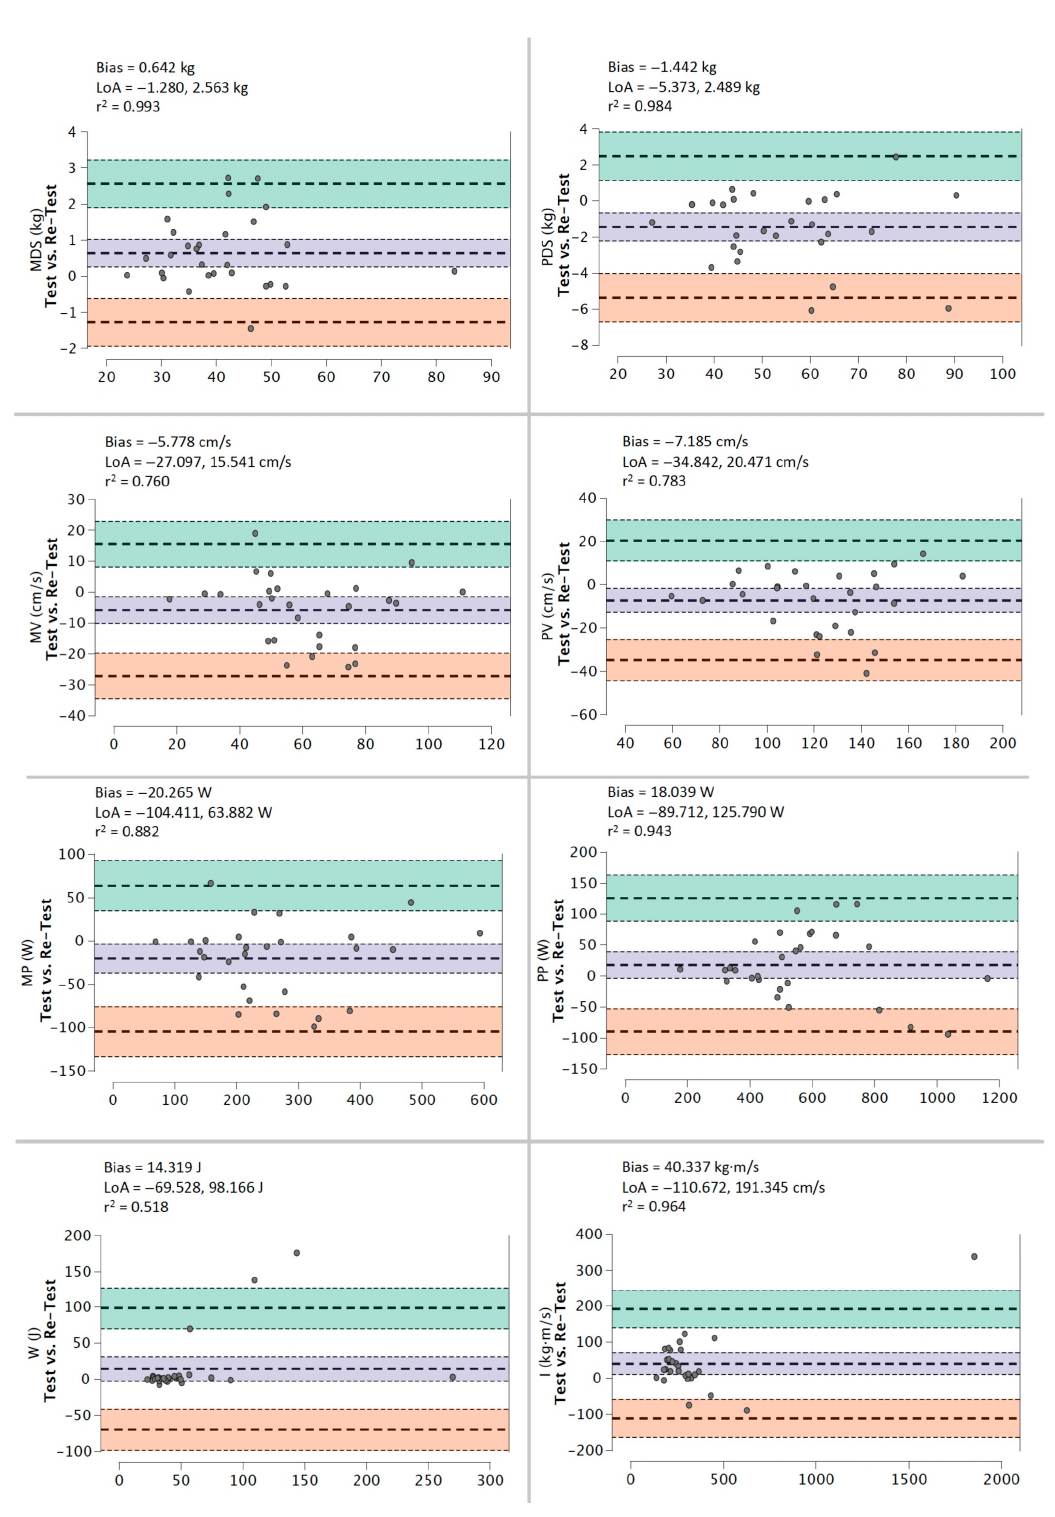
Figure 3. Bland-Altman plots of test–retest for MDS, PDS, MV, PV, MP, PP, W, and I during 50% 1RM protocol using a DEMF.